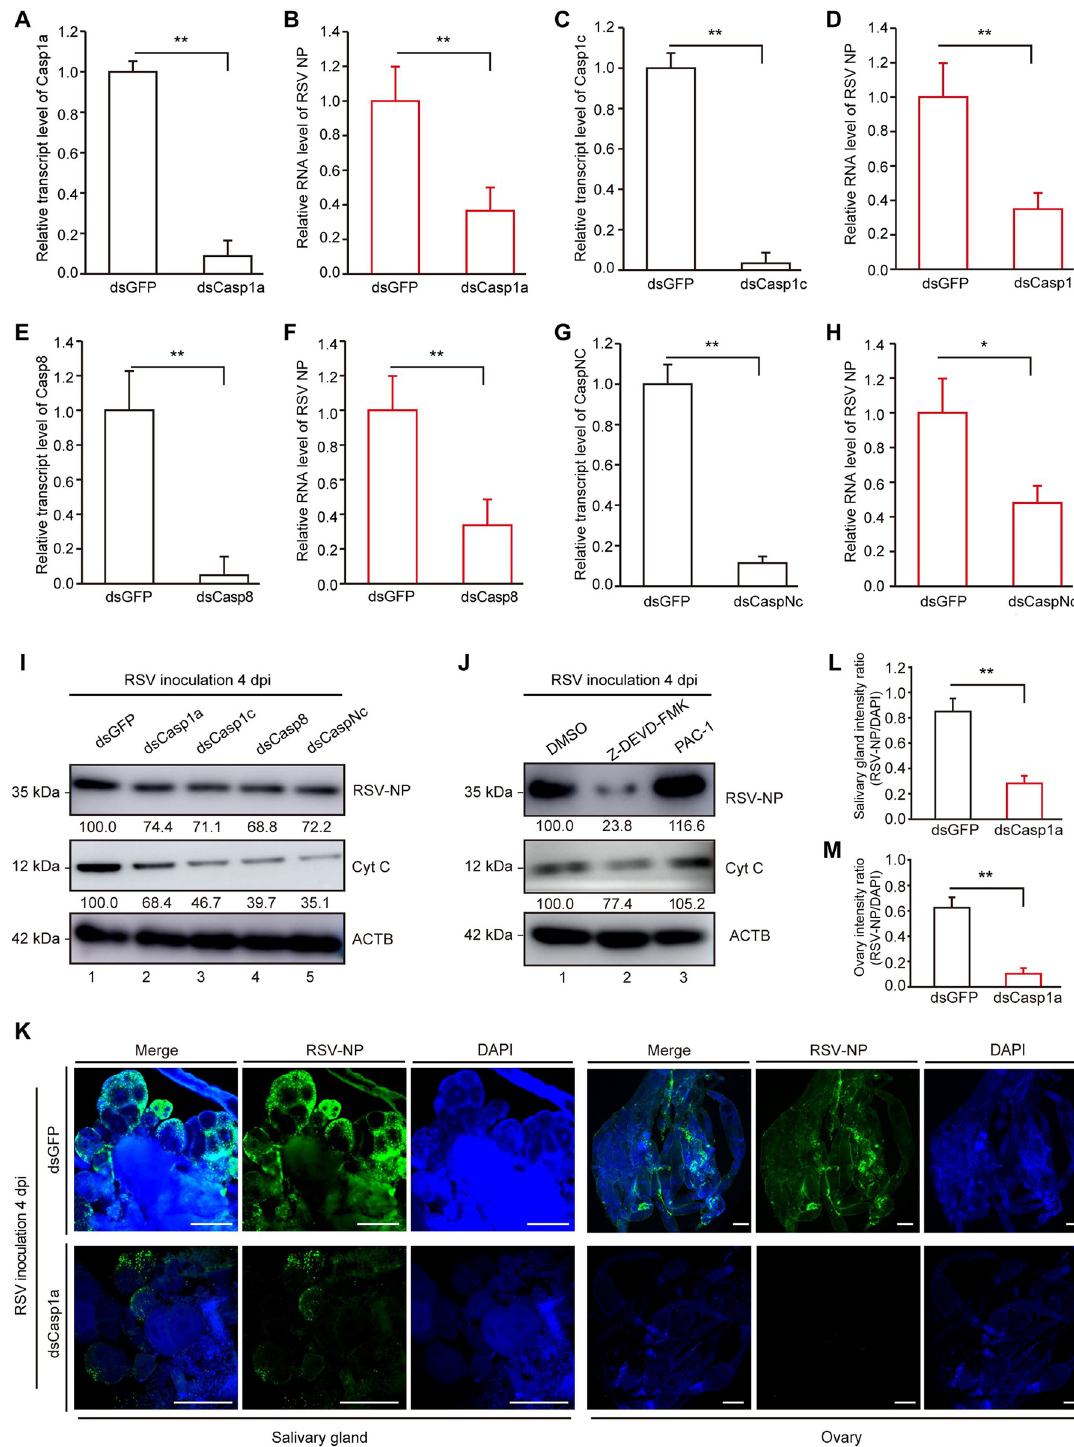
Fig 2. Effects of apoptosis on virus accumulation in insect vectors. After silencing of four apoptotic factors, [Casp1a (A), Casp1c (C), Casp8 (E) and CaspNc (G)], the accumulation of RSV NP at RNA level (B, D, F, H) and protein level (I) were detected at 4 dpi. (J) Western blotting analysis of RSV NP and Cyt C in SBPHs that fed with apoptosis inhibitor Z-DEME-FMK or apoptosis activator PAC- 1. SBPHs that fed with DMSO were acted as the control group. (K) Immunofluorescence labeling of RSV NP (green) in salivary glands and ovaries from ds Casp1a - or ds GFP -treated SBPHs at 4 dpi. Nuclei were stained with DAPI (blue). Bar, 100 μ m. (L–M) Fluorescence